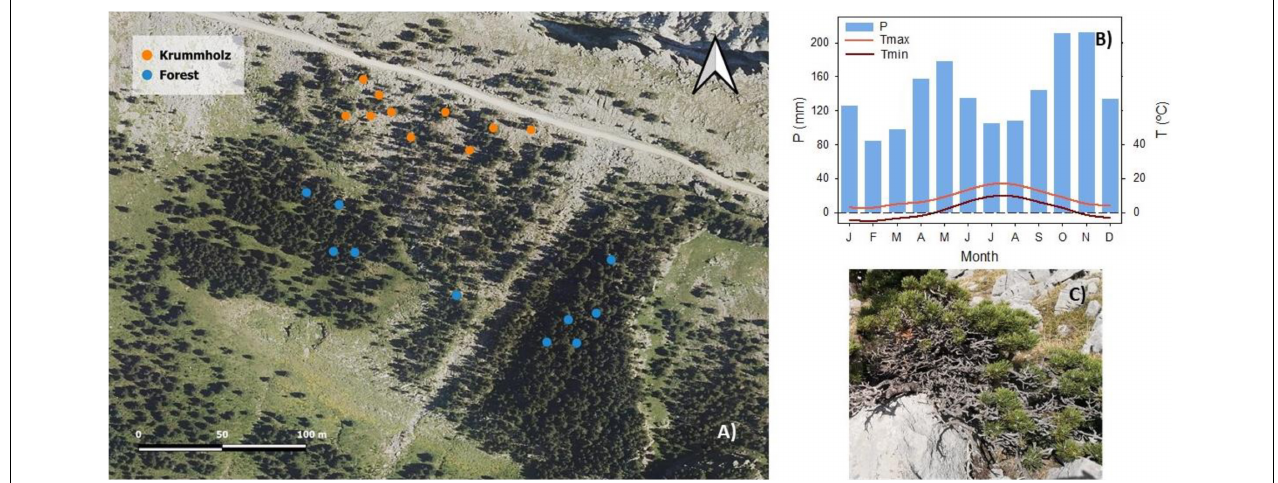
FIGURE 1 | (A) Orthoimage obtained from the Spanish National Plan for Aerial Orthophotography (PNOA) corresponding to the year 2018 of Sierra de Las Cutas in the Spanish Pyrenees. Each point in the image corresponds to an individual ( n = 10 per population). (B) Climograph of the study site, obtained from the climatic data of the Goriz Refuge located in the Ordesa y Monte Perdido National Park (Huesca, Spain) collected during the years 1981–2018. The monthly average precipitation (P), the monthly average maximum (Tmax), and minimum (Tmin) temperature are shown (Serrano-Notivoli et al., 2018). (C) Specimen of Pinus uncinata with the characteristic Krummholz mat